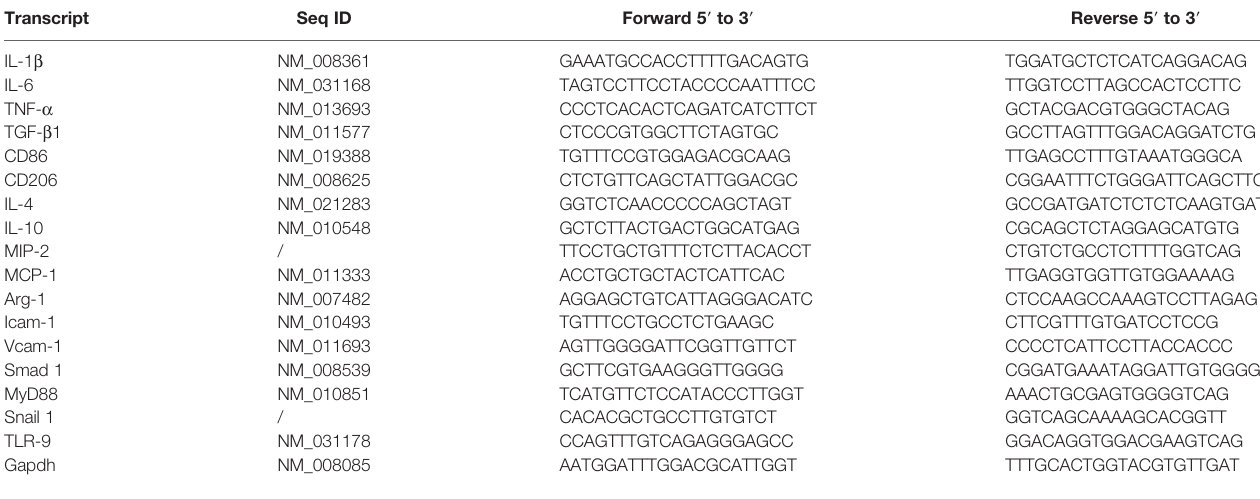
TABLE 1 | Primer sequences for Real-time quantitative